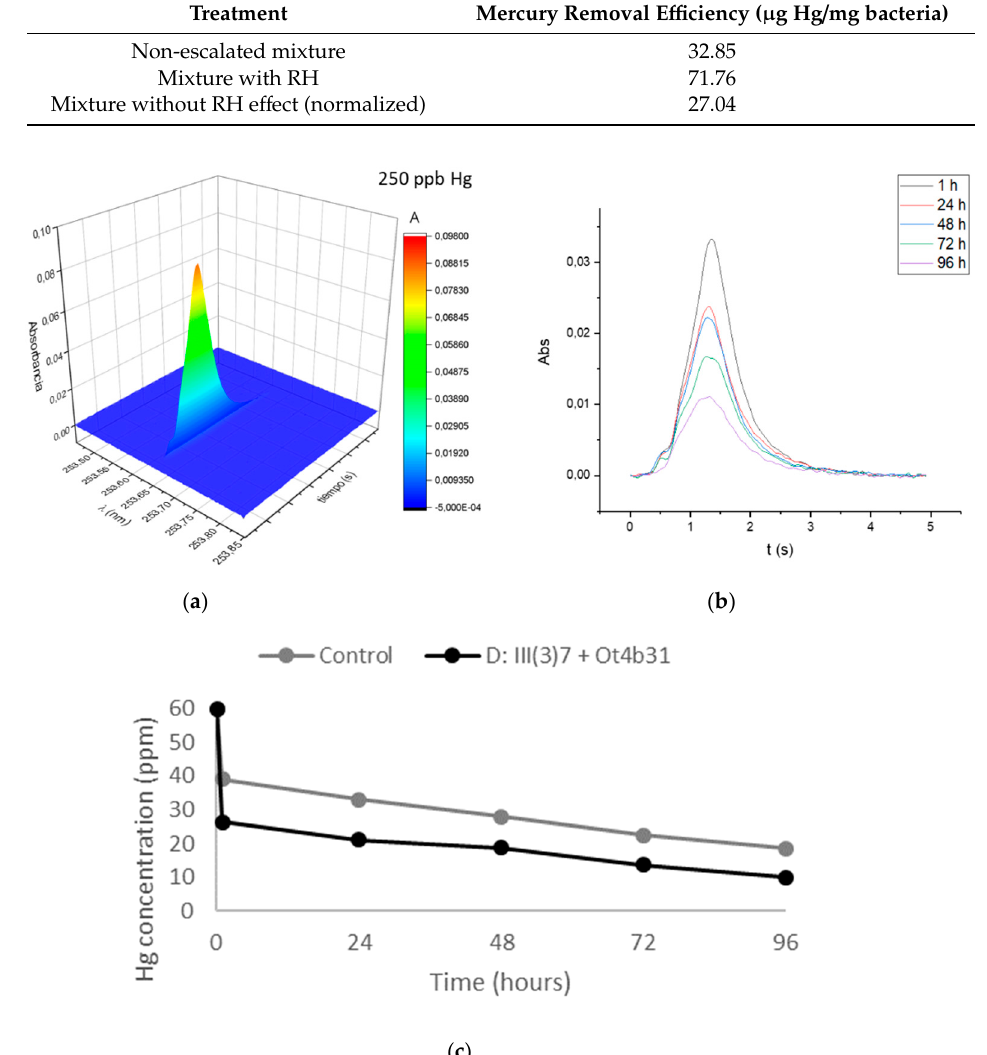
Figure 3. GF-AAS quantification of Hg aliquots of escalated process. ( a ) Hg signal of standard solution diluted 1/240. ( b ) Time-resolved absorbance signals for samples. ( c ) Hg concentration over time in escalated process with (black) and without bacteria (grey).